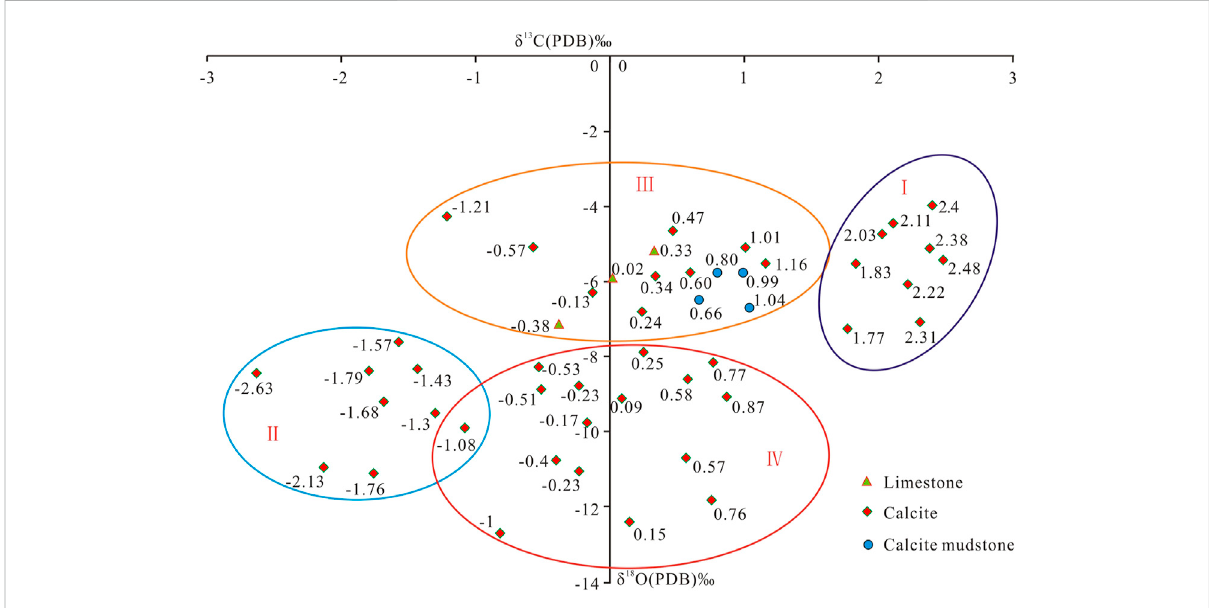
FIGURE 5 Bivariate δ 13C- δ 18O plot of Ordovician paleokarst fi ssure fi lings from the Tazhong region. Roman numerals refer to developmental periods shown in Table 2.